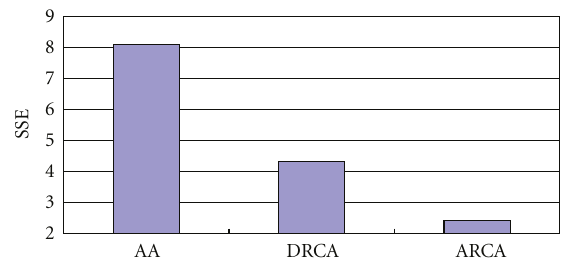
Figure 2: Sum of squared errors in Case 1.